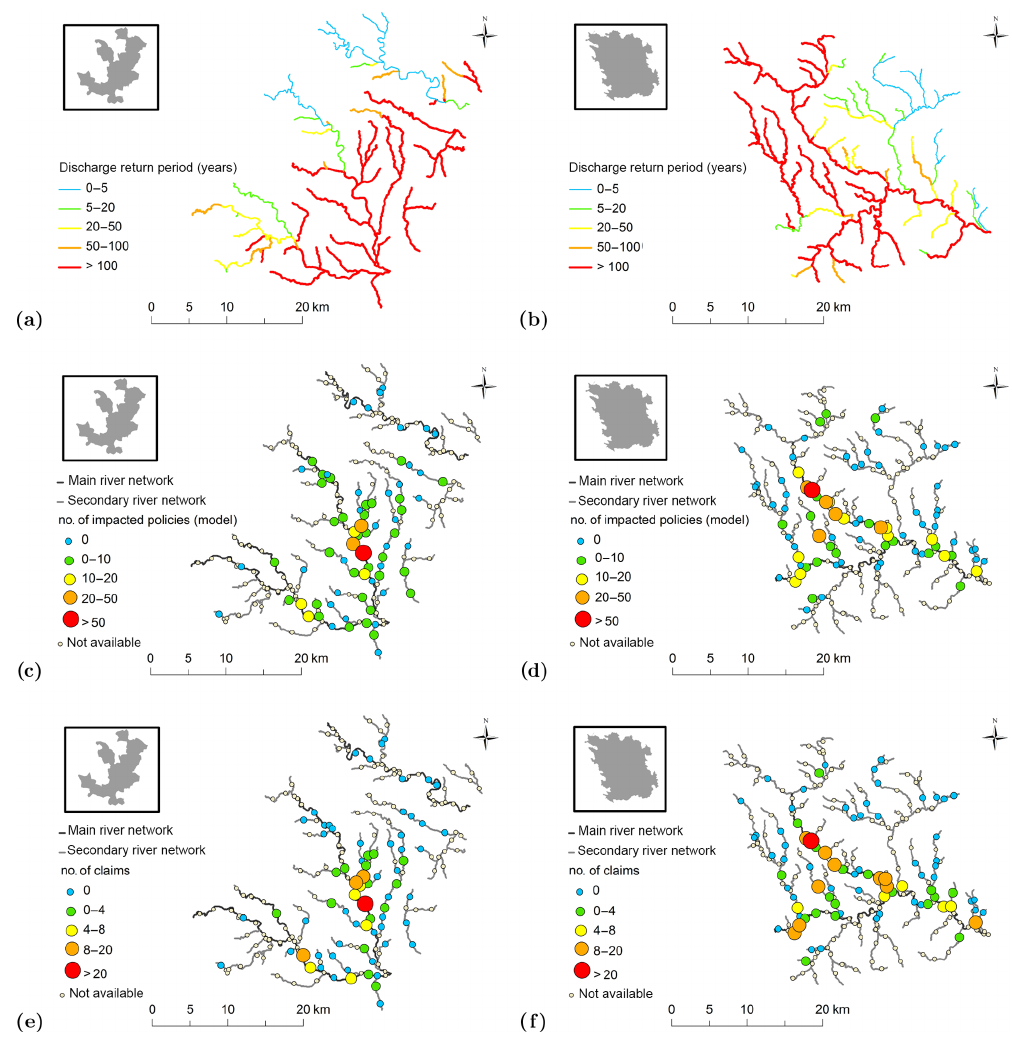
Figure 9. Maps of the peak discharges (return periods) and related impacts (number of flooded policies) simulated by the model, and of the number of claims extracted from the CCR database: (a) peak discharges, Alès 2002; (b) peak discharges, Draguignan 2010; (c) estimated impacts, Alès 2002; (d) estimated impacts, Draguignan 2010; (e) claims, Alès 2002; (f) claims, Draguignan